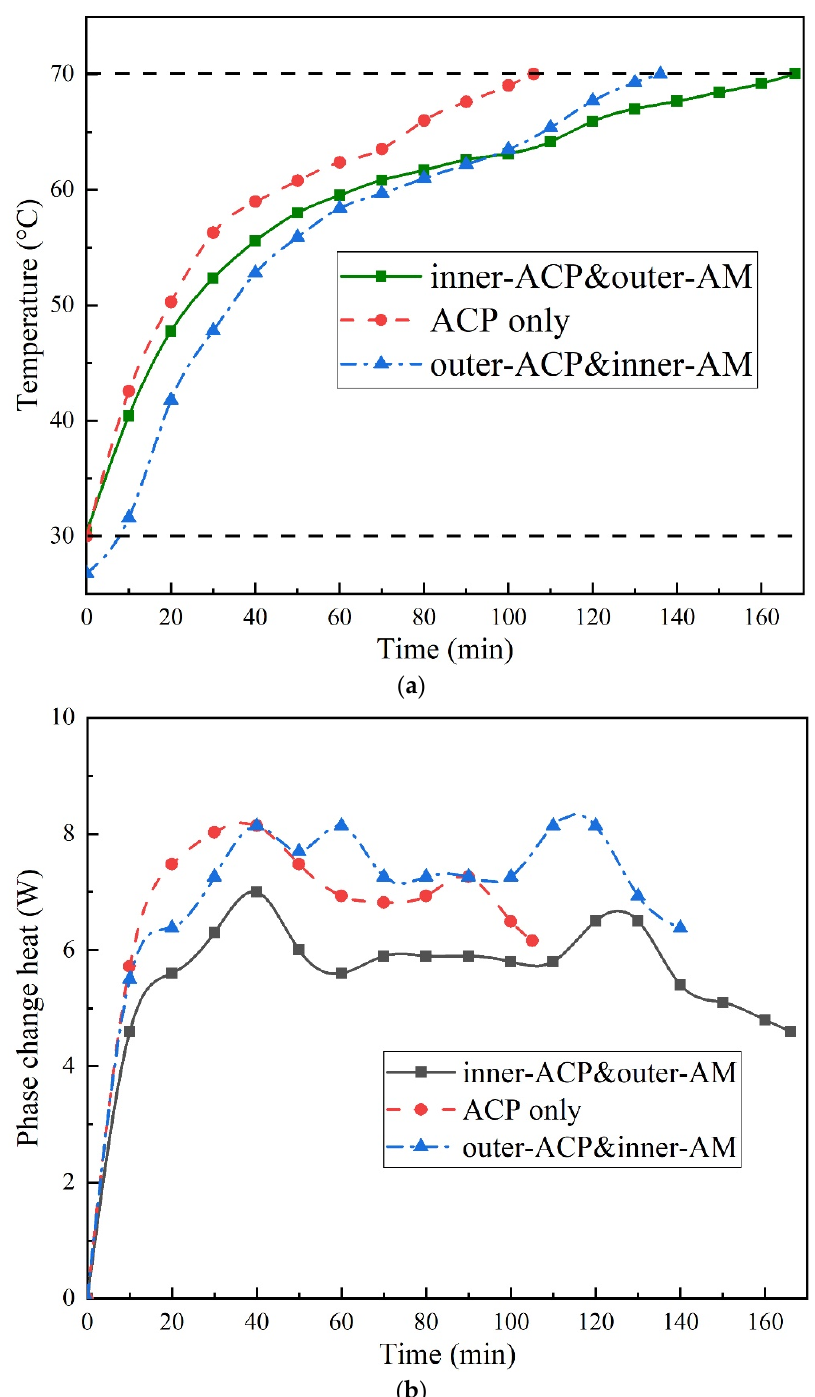
Figure 6. Comparison of thermal − protection performances with different insulation layouts. ( a ) In- ner − wall temperature. ( b ) Phase change of absorbed heat. ( a ) Inner − wall temperature. ( b ) Phase change of absorbed